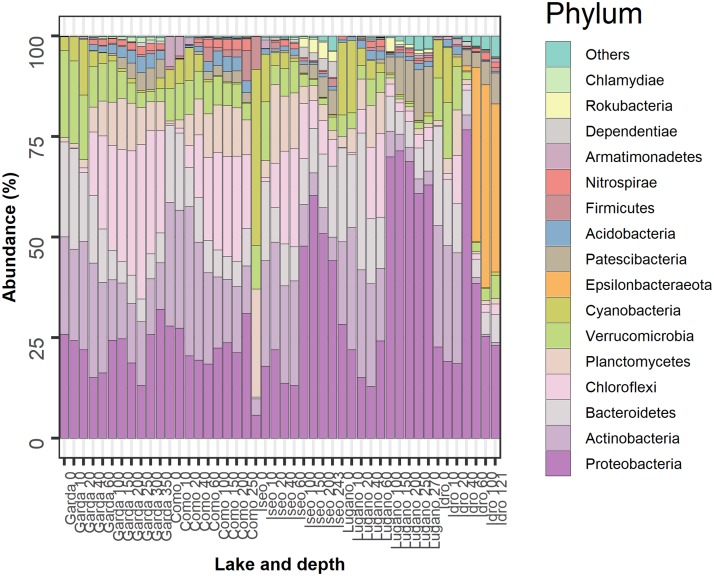
Temporal development of the 16 more abundant phyla in the 5 lakes. Samples are coded by the name of the lake and depth (meters). The bars report the percentage contributions on the sample totals. The bacterial groups were selected identifying, for each lake, the 12 more abundant phyla. The high fraction of cyanobacteria at the surface of Lake Iseo was caused by a higher development of Dolichospermum lemmermannii.